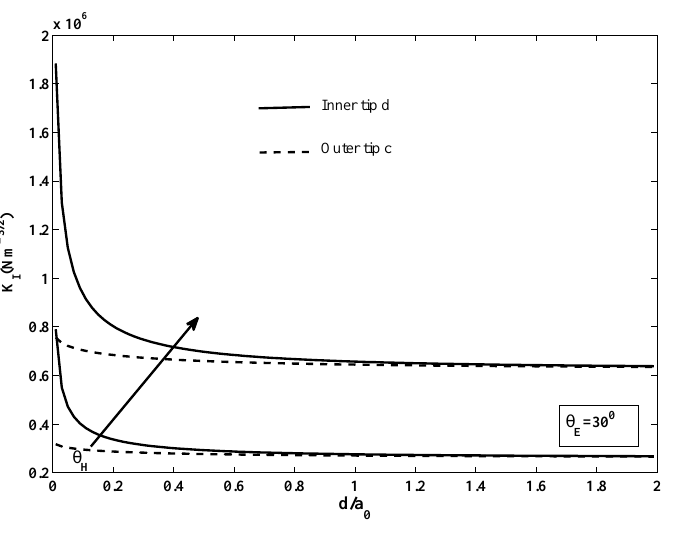
Fig. 12 SIF versus inter-crack distance for different magnetic poling with fixed electric poling